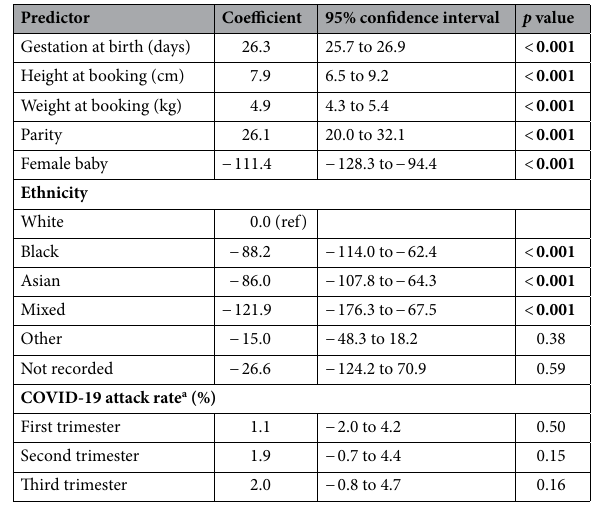
Table 2. Regression statistics for linear regression model of birth weight (g). The COVID-19 attack rate (% of population contracting COVID-19 during a specified time interval) was calculated using modelled transmission data 20 and is used here as a proxy for COVID-19 exposure in each trimester. Significant values are in